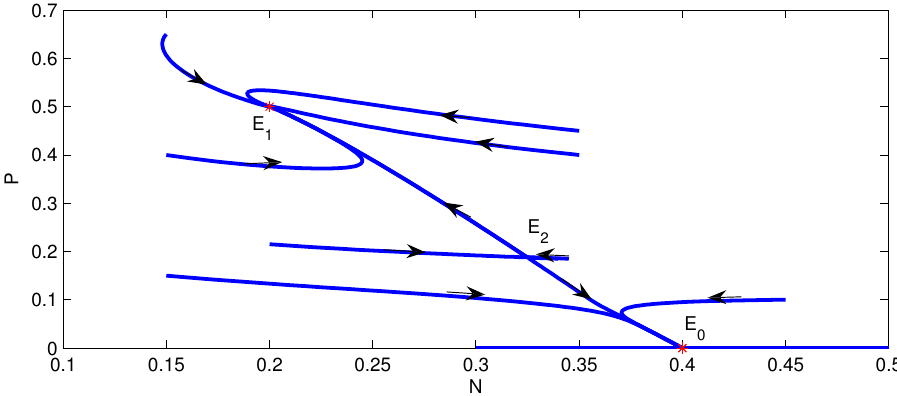
Figure 6. The phase portrait of model Equation (3) when E 0 and E 1 are locally asymptotically stable and E 2 is unstable.